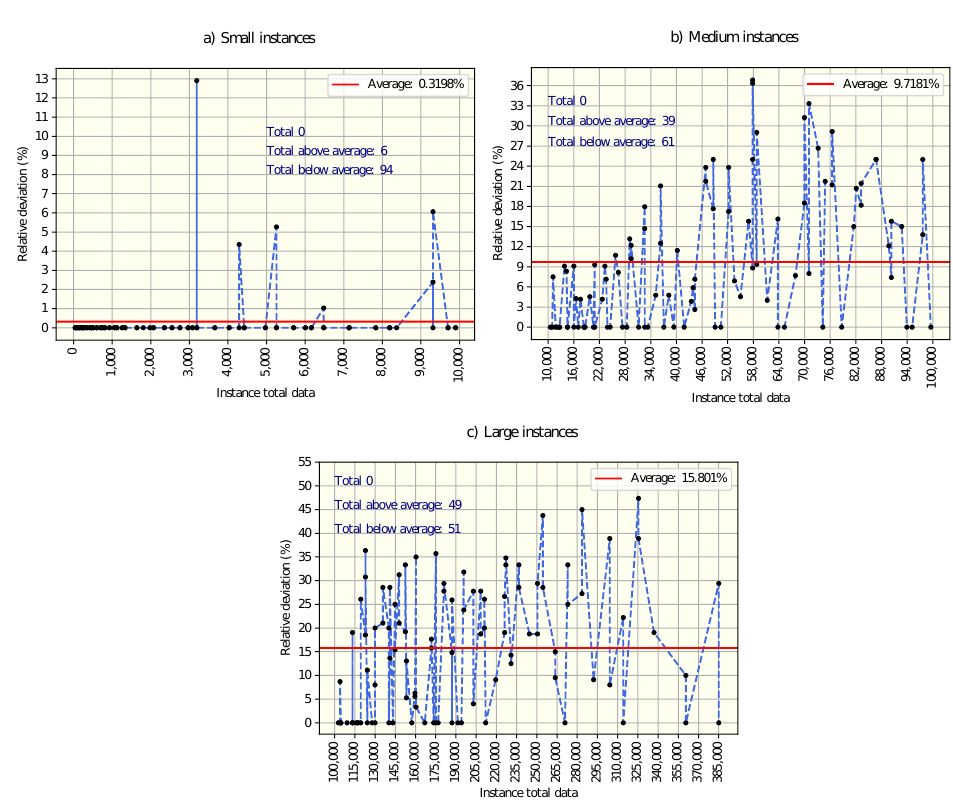
Figure 5. Relative deviation for: ( a ) Small, ( b ) Medium and ( c ) Large instances.